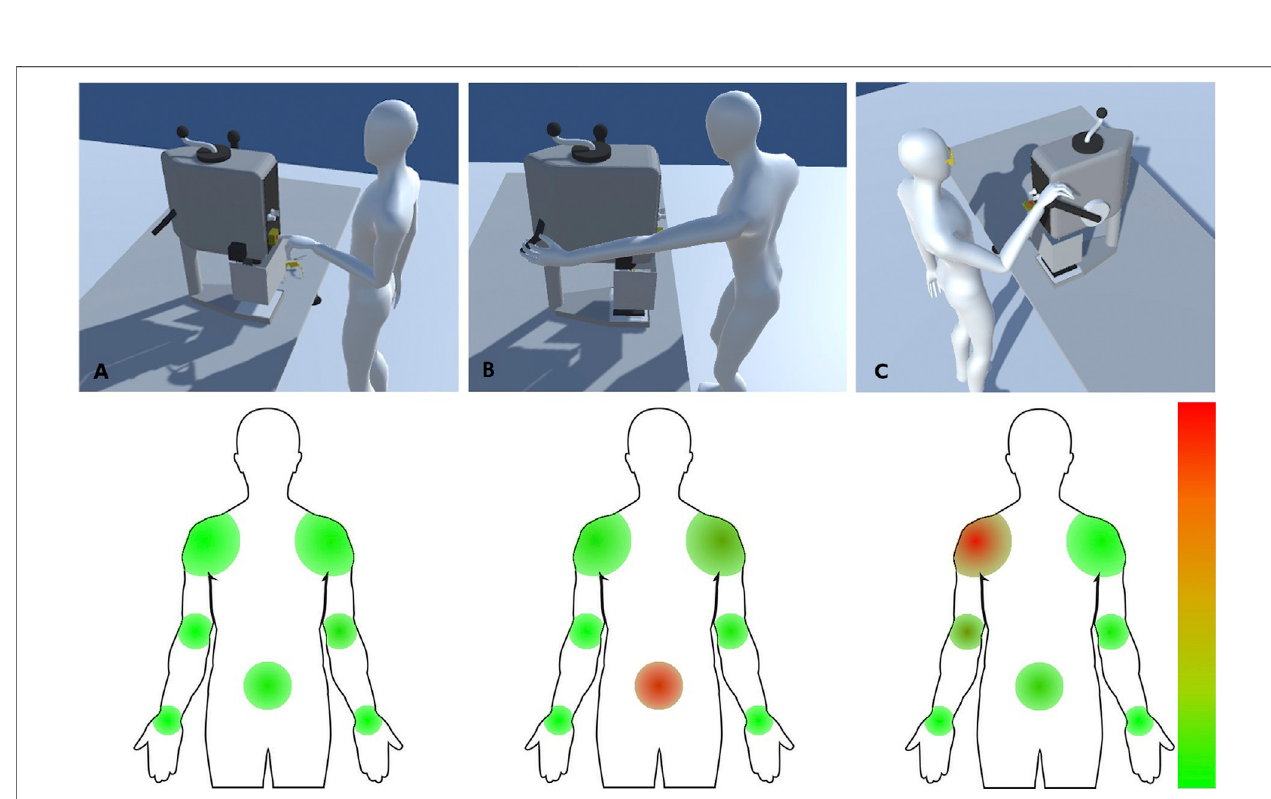
FIGURE 11 | Snapshots of the training scenario visualized in the simulation module (top row) and corresponding heatmaps calculated in the biophysics assessmentmodule (bottomrow) . (A) Step1, (B) step6and (C) step12.Theheatmapateachjointsigni fi estheaccumulated(withinatimewindowof1 s)energyatthe current step normalized by the maximum accumulated joint energy for all steps. The color scale from green to red color corresponds to 0 to 33.54 J, respectively.